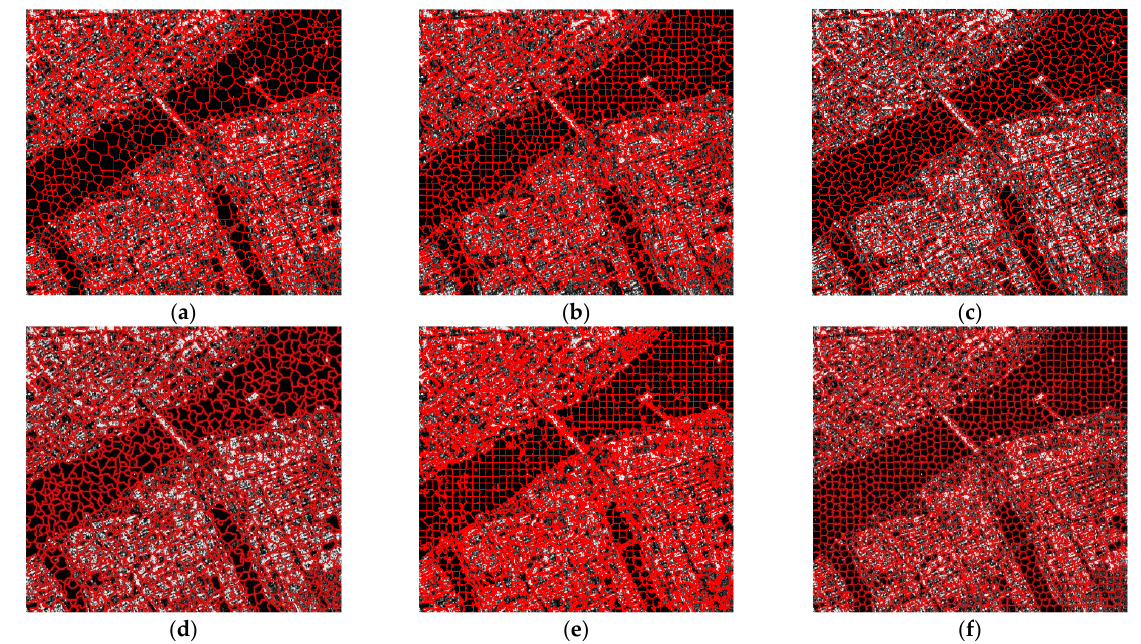
Figure 20. Superpixel generation results for the real SAR image SI 6 . ( a ) SLIC, ( b ) SNIC, ( c ) SEEDS, ( d ) SPAMP, ( e ) CAS, and ( f ) EDTRS.